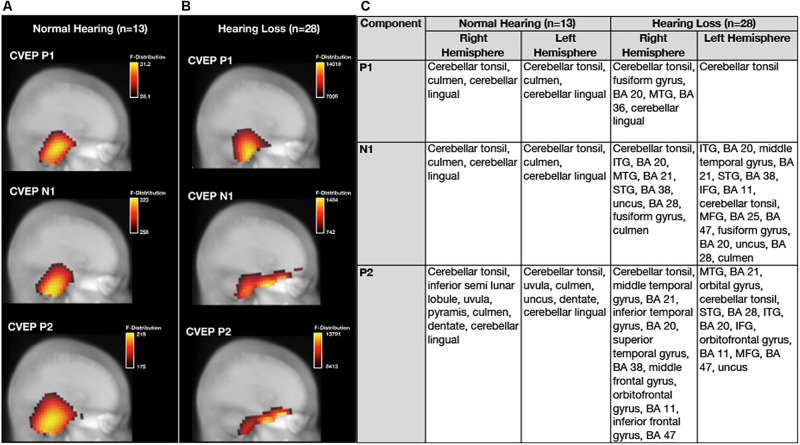
Baseline group differences in cortical source activation patterns elicited by visual motion stimuli. Baseline Current density source reconstructions (CDR) for the P1, N1, and P2 cortical visual evoked potential components for the normal hearing group (n = 13) are depicted in (A) and CDRs for the hearing loss group (n = 28) are depicted in (B). 3D current density source reconstructions obtained via standardized low-resolution brain electromagnetic tomography (sLORETA) are projected on a 2D depth-buffered structural magnetic resonance image (Maximum Intensity Projection), providing visualization of the voxels with the highest likelihood of activation. The color scale to the right of each figure shows the statistical likelihood of activation (F-statistic), from lowest (red) to highest (yellow) probable current density. (C) Describes regions of cortical source activity for each CVEP component, including Brodmann areas (BA), for the normal hearing and age-related hearing loss group by rank in order highest to lowest likelihood of activation (F-statistic).